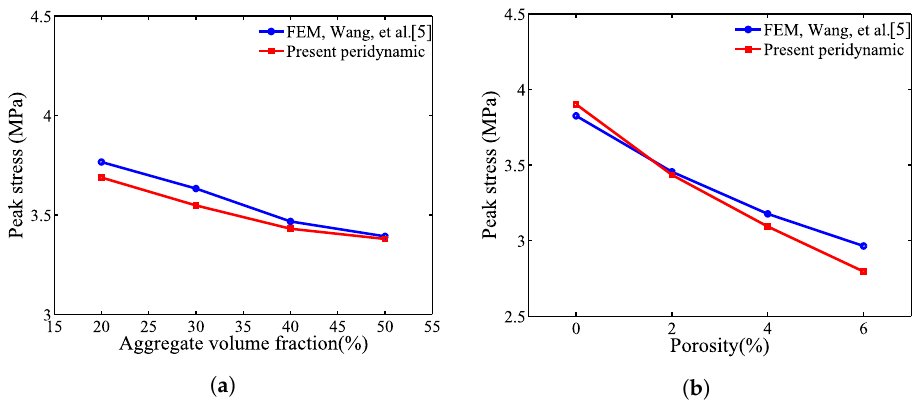
Figure 14. Mean peak stress for varying ( a ) aggregate volume fraction, P agg , and ( b ) porosity, P pore .